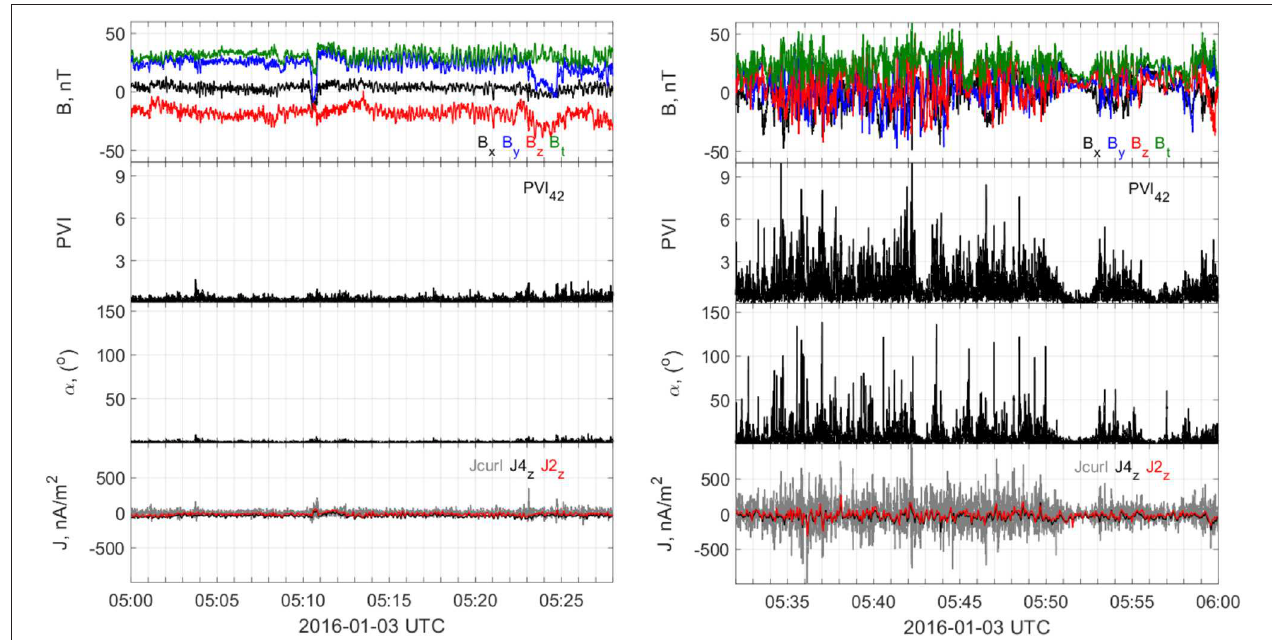
FIGURE 2 | (Left) from top to bottom: Magnetic field magnitude and components, PVI for MMS4 and MMS2 pair of spacecraft, magnetic shear angle, and current density from curlometer (J curl , gray) and plasma currents for MMS4 (J4 z , black) and MMS2 (J2 z , black) in the Q ⊥ MSH; (Right) Same as on the left in the Q || MSH.